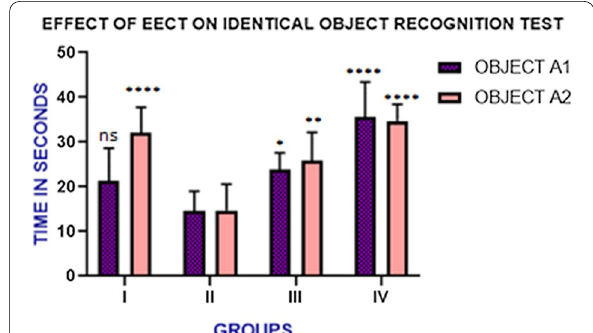
Fig. 2 Effect of EECT on identical object recognition